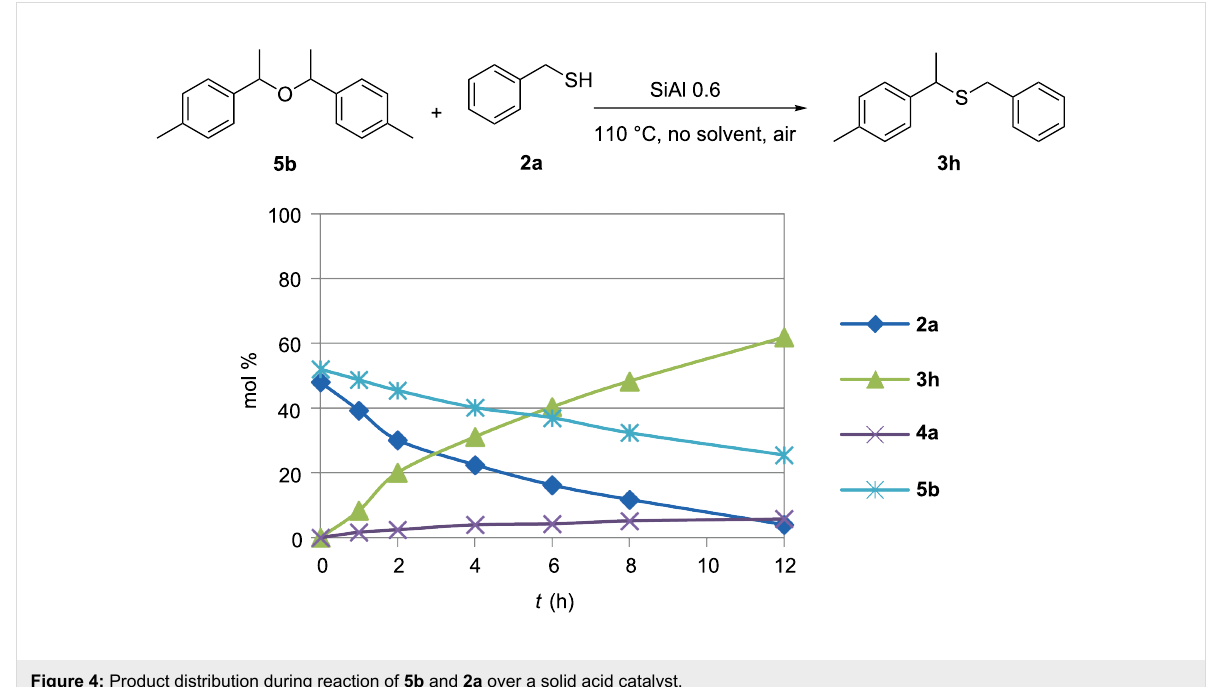
Figure 4: Product distribution during reaction of 5b and 2a over a solid acid catalyst.